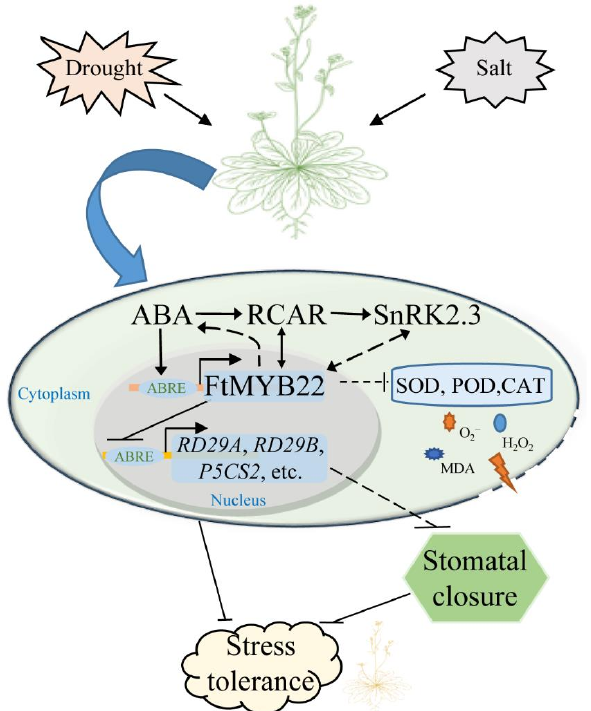
Figure 16. Hypothetical regulatory model of the FtMYB22 responding to abiotic stress. The solid lines represent confirmed conclusions and dashed lines represent hypothetic pathways.